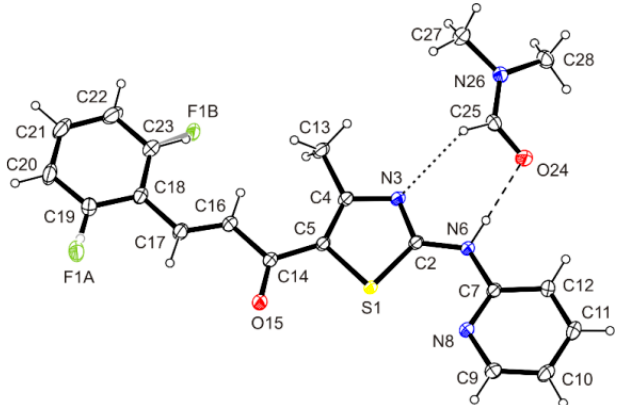
Figure 2. ORTEP view of 3 *DMF showing the atomic labelling scheme. Non-H atoms are drawn as 30% probability displacement ellipsoids and H atoms are drawn as spheres of arbitrary size. Table 1. Hydrogen-bond geometry (Å, o ) for ( 3 *DMF).